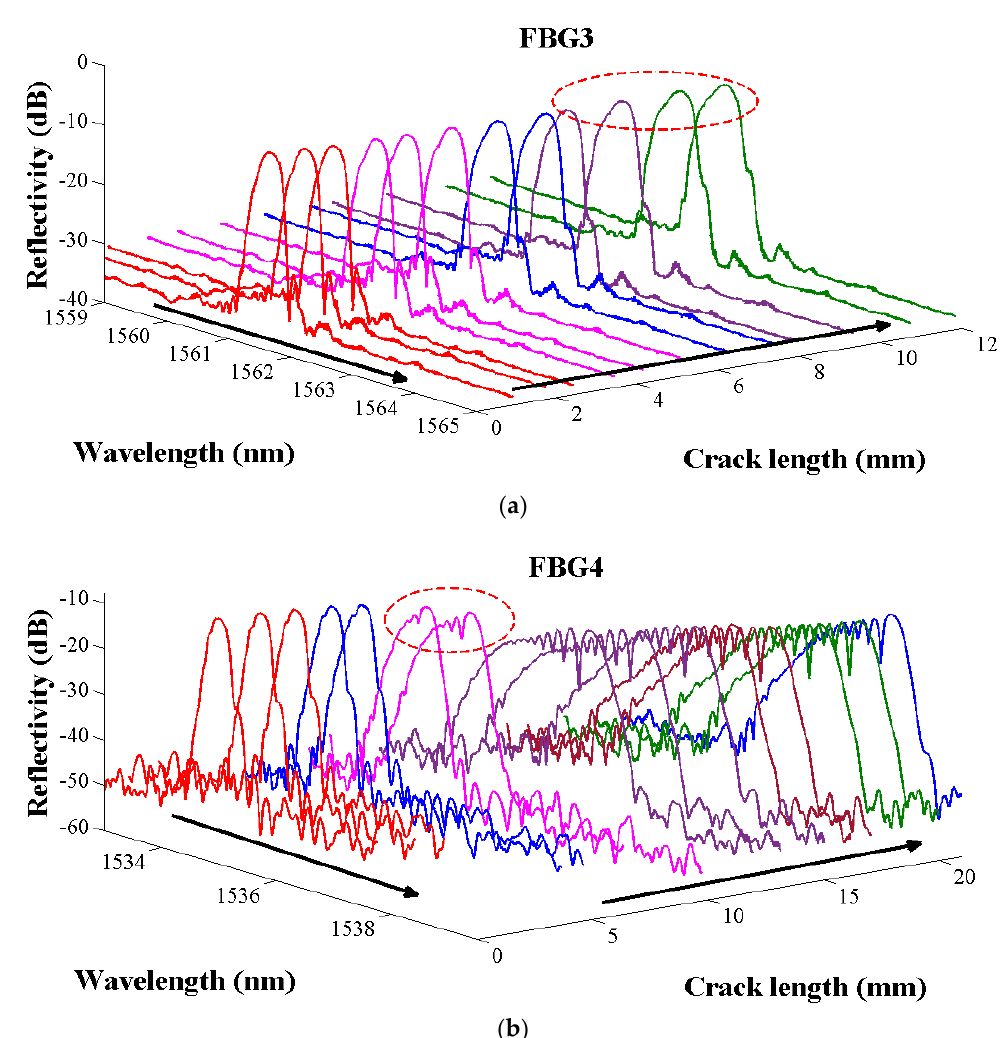
Figure 17. The FBG3 and FBG4 reflection spectrum in various crack lengths. ( a ) The reflection spectrums of FBG3 in different crack lengths, ( b ) The reflection spectrums of FBG4 in different crack lengths.